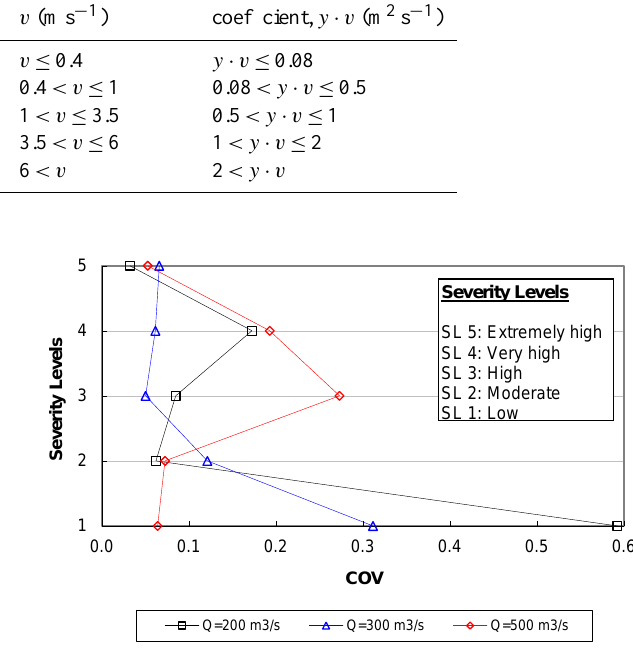
Fig. 23. 2-D SWE model. Coefficient of variation (COV) of the ex- tension of the area foir each severity